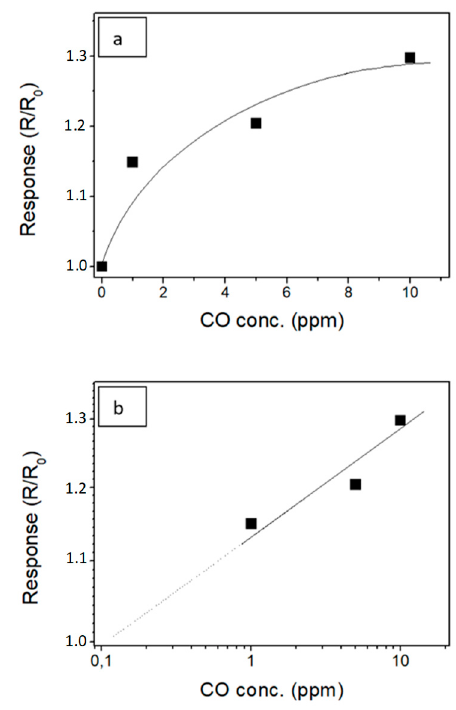
Figure 9. ( a ) Calibration curve showing the sensor response to different CO concentrations under the “UV On in air” method; ( b ) calibration curve plotted in log-log scale.